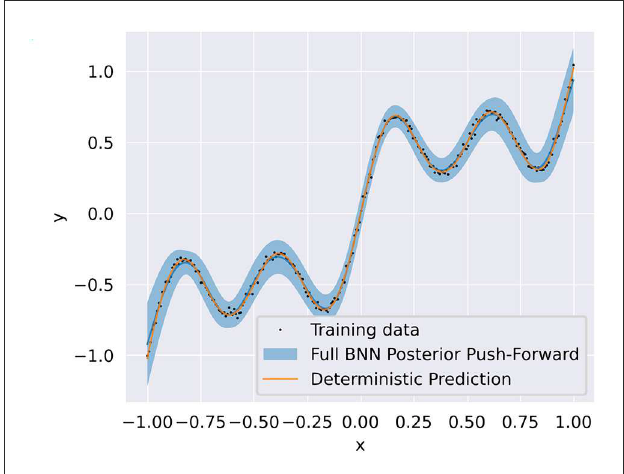
FIGURE3 Training data (black dots) overlaid with the deterministic DNN prediction (solid orange) and full BNN posterior push-forward uncertainty (solid blue line is the mean, blue shadow is the 95% credible